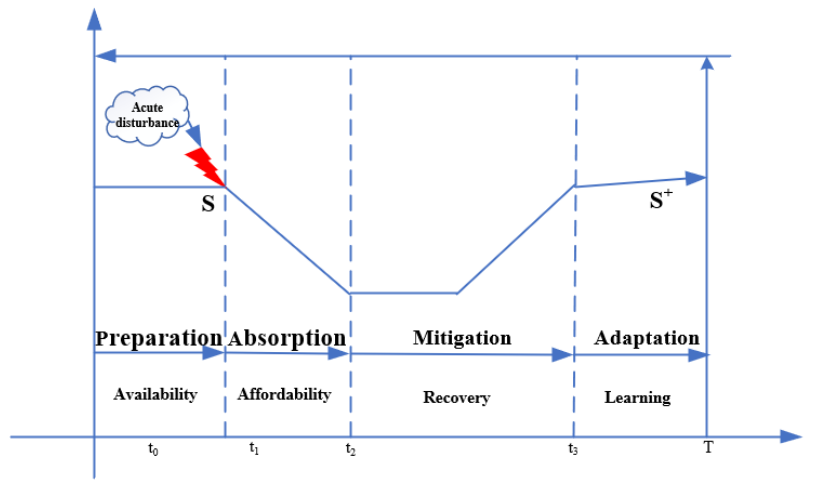
Figure 1. The evolution mechanism of energy resilience.